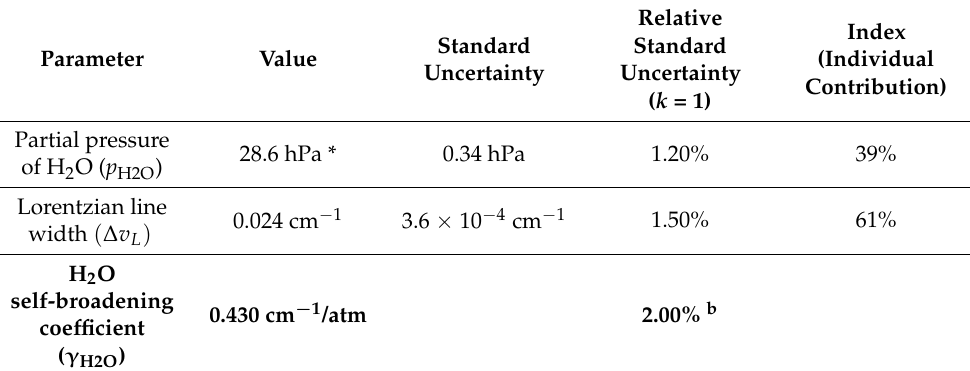
Table 2. Uncertainty budget for the self-broadening coefficient γ H2O in this work.